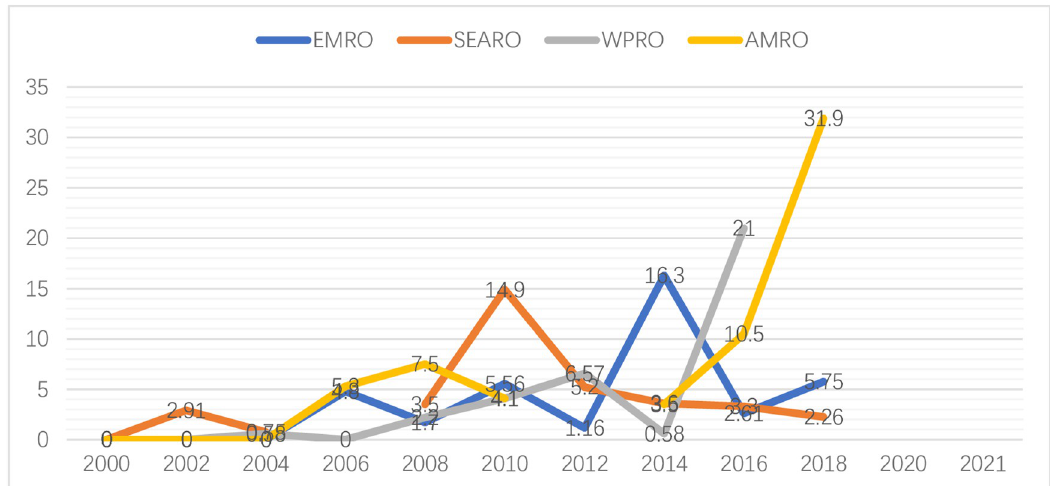
Fig 3. Prevalence of URE by GBD sub-regions from 2000 to 2021